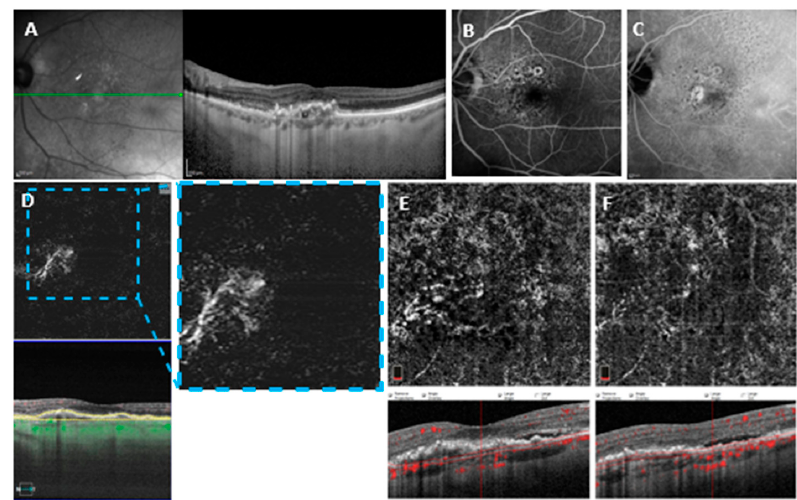
Figure 3. ( A ). SD-OCT. crossing through the lesion showing a flattened irregular PED ( B ). Early fluorescein angiography ( C ). Late indocyanine green angiography with late hyperfluorescent fluorescein angiography. ( C ) Late indocyanine green angiography with late hyperfluorescent plaque. plaque ( D ). ( E ) En face and cross-sectional 6× 6 mm 2 SS OCTA with PlexElite MS Custom segmen- ( D ) En face and cross-sectional 6 × 6 mm 2 SS-OCTA with PleXelite MS Custom segmentation showing tation showing distinct flow overlay Z. ( F ) Zn face and cross-sectional 3 × 3 mm 2 SD-OCTA with distinct flow overlay. ( E ) En face and cross-sectional 3 × 3 mm 2 SD-OCTA with AngioVue corrected AngioVue automated segmentation showing no detectable flow. manual segmentation. ( F ) En face and cross-sectional 3 × 3 mm 2 SD-OCTA with AngioVue automated segmentation showing no detectable flow.